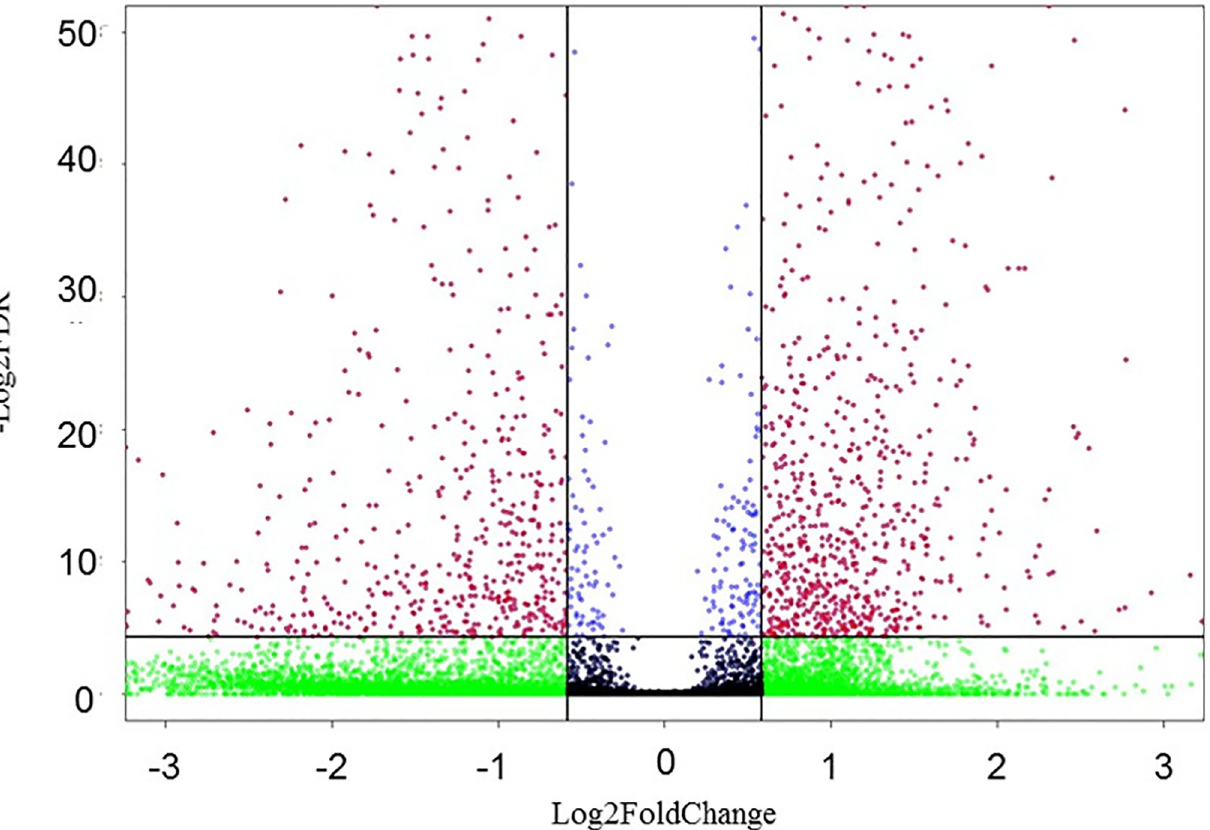
Fig 1. Volcano plot of differentially expressed genes of infected cells (APEC-O78 infection) and non-infected cells (Control). Red dots represent up- regulated genes, green, blue and black dots represent non-differentially expressed genes (Fold Change > 1.5 or Fold Change < 0.667, FDR < 0.05). The horizontal axis represents the fold change between infected and control cells. The vertical axis represents the FDR-value of the multiple-test for the differences between samples.